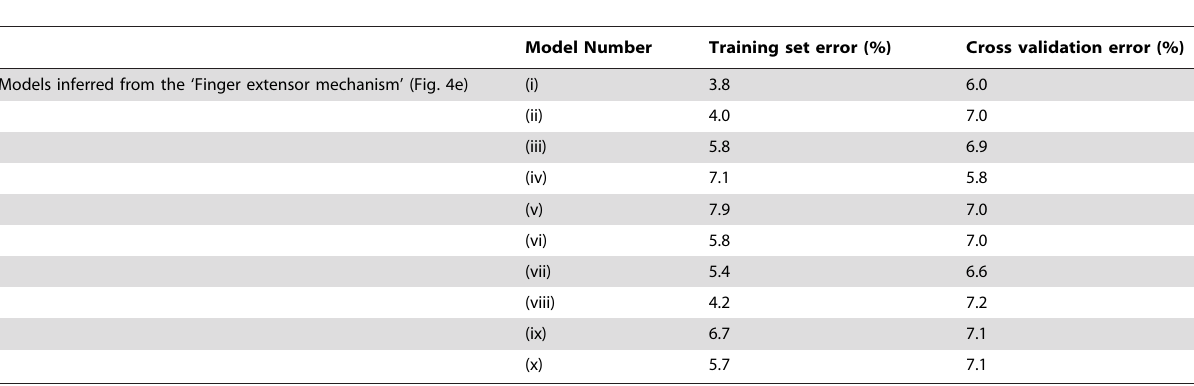
Table 2. Training set and cross validation errors of the ten best models inferred through the informative force-motion data obtained from the finger extensor mechanism.